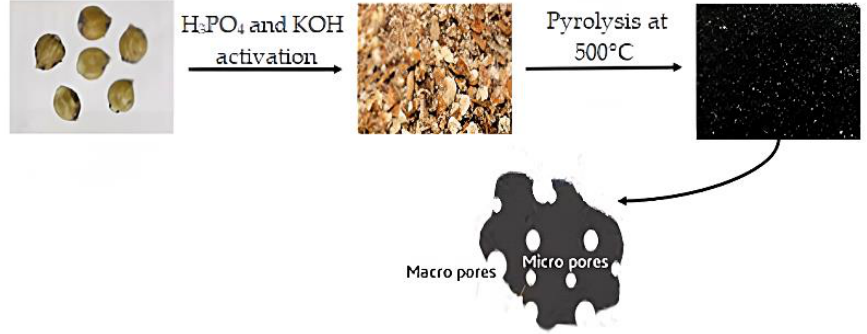
Figure 1. Schematic procedure for BGS-derived biochar preparation.